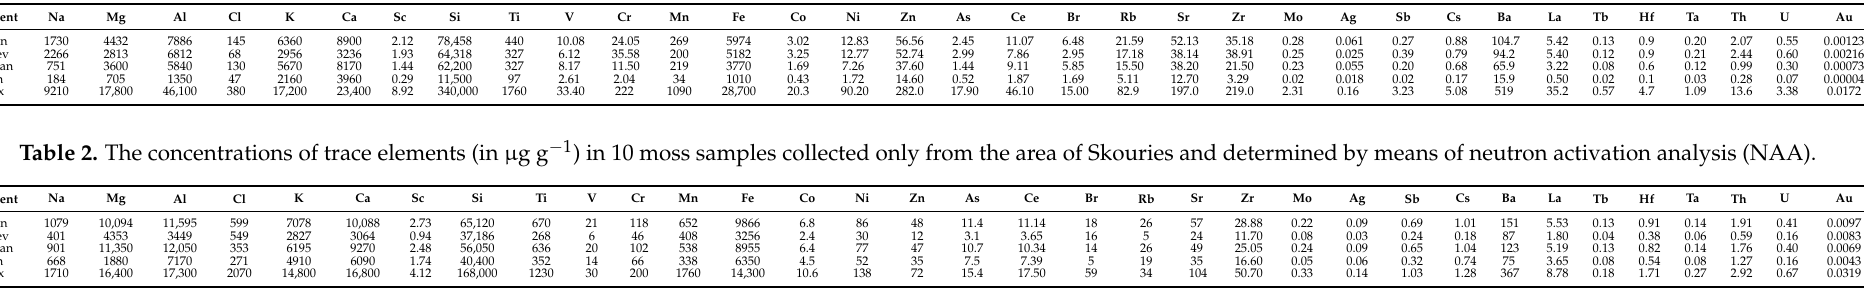
Table 1. The elemental concentrations (in µ g g − 1 ) in 95 moss samples collected in Northern Greece and determined by means of neutron activation analysis (NAA).